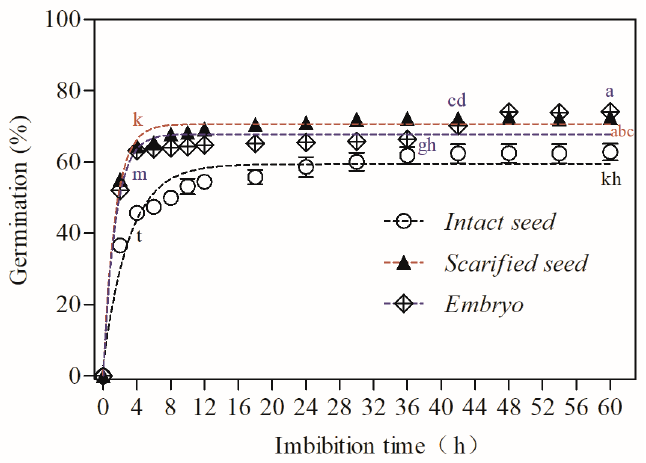
Figure 4. Water absorption curves of the intact seeds, scarified seeds, and excised embryos of Eucommia ulmoides . The intact seeds, scarified seeds, and excised embryos were allowed to absorb water in the dark at 10 ◦ C, following which they were weighed. Each treatment had four replicates and 30 seeds or excised embryos were used for each replicate. The percentage of water absorption was expressed as mean ± standard error. The 0 in the x-axis denotes the control (CK). There are no significant differences between the data labeled with the same lower case letters ( p = 0.05).